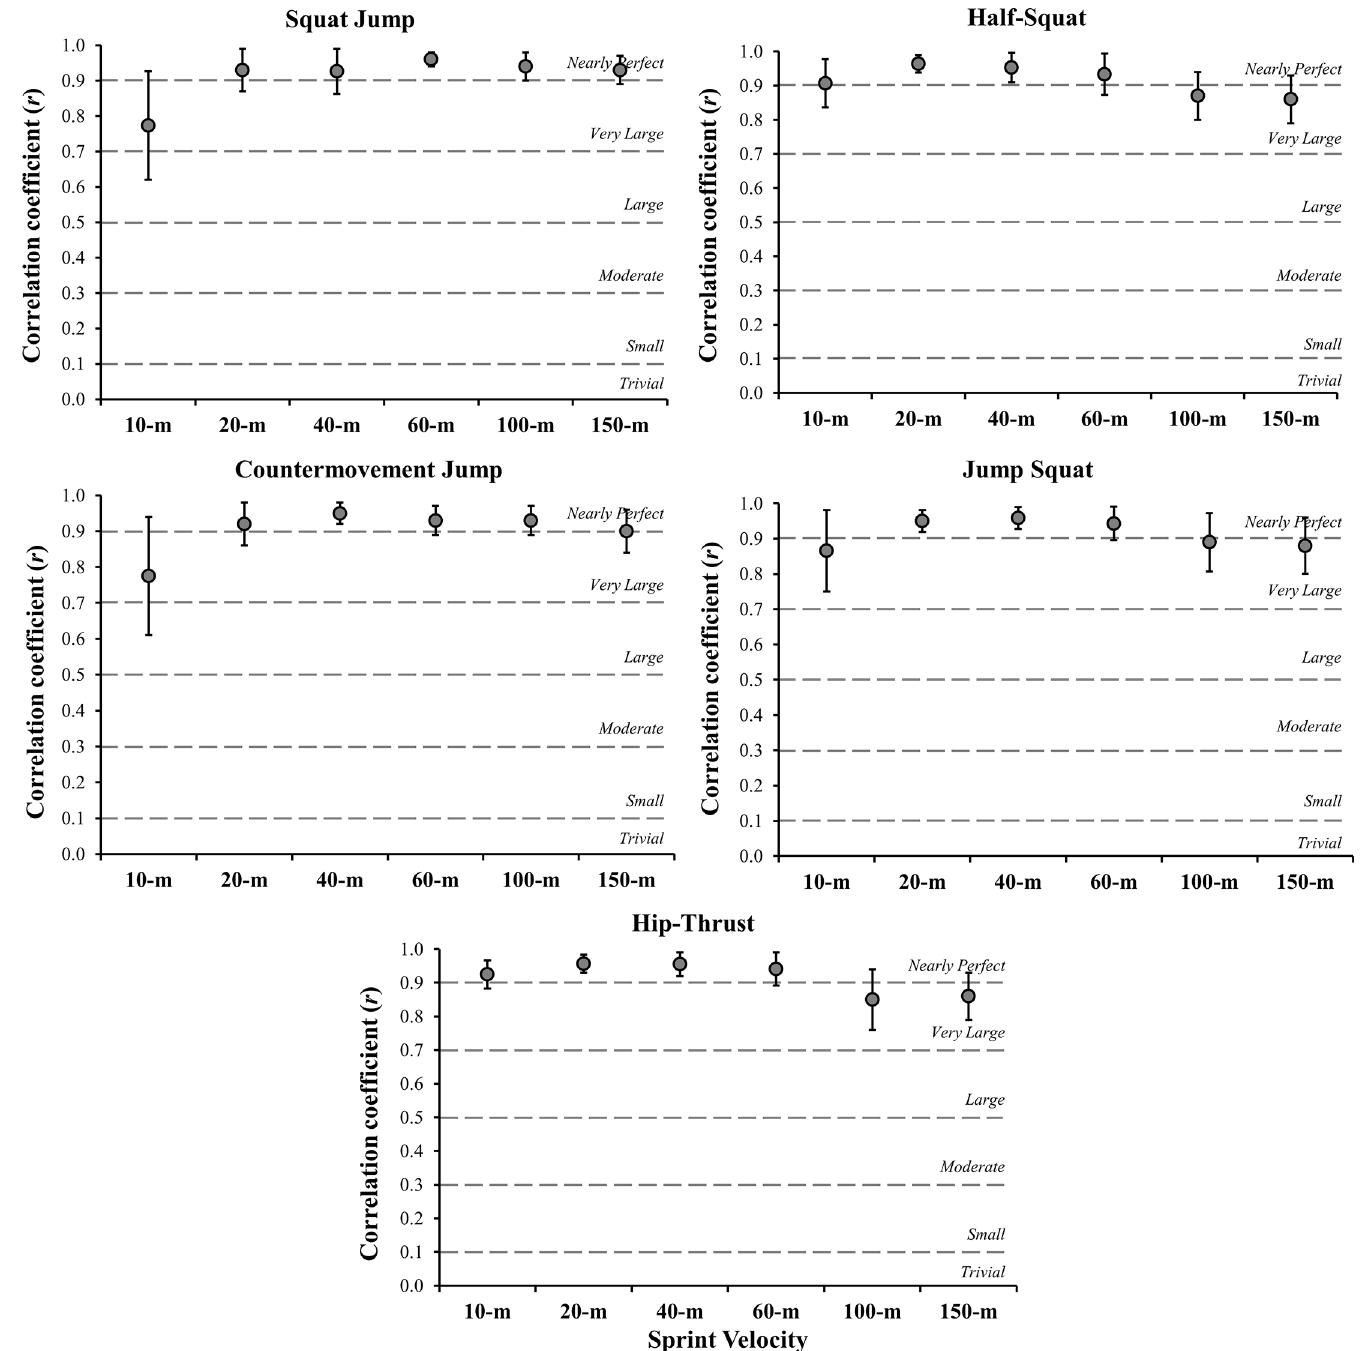
Fig 3. Correlations (90% confidence limits) between sprinting velocities for the different distances tested with squat and countermovement jumps (SJ and CMJ), and the mean propulsive power (MPP) in the half-squat (HS), jump squat (JS), and hip-thrust (HT) exercises. P < 0.05 for all correlation